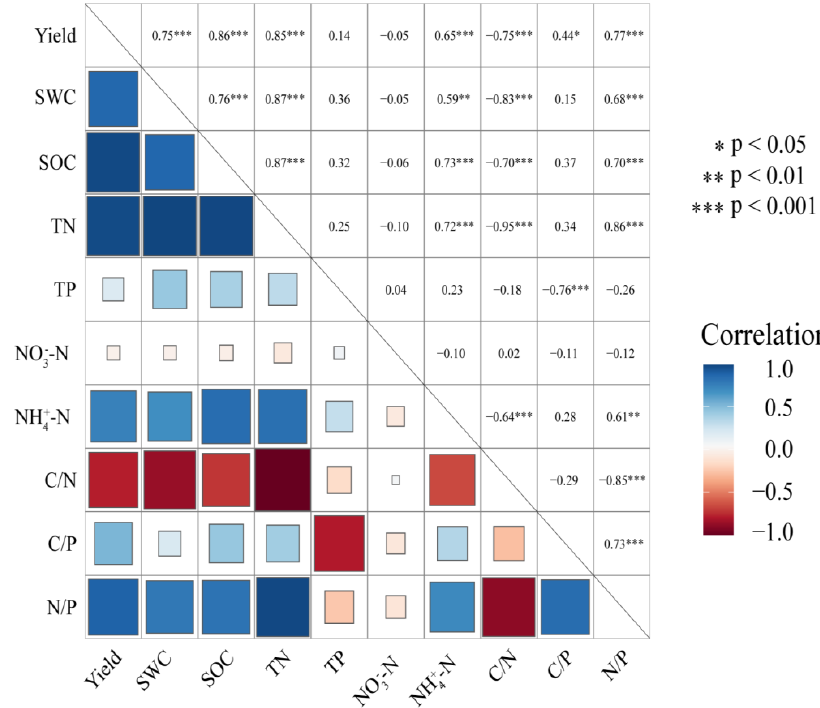
Figure 6. Correlation heat map of spring wheat yield, soil nutrients, and stoichiometric character- istics. SWC: gravimetric soil water content, SOC: soil organic carbon, TN: total nitrogen, TP: total phosphorus, NO 3 − -N: nitrate nitrogen and NH 4 + -N: ammonium nitrogen, C/N: soil carbon and total nitrogen ratio, C/P: soil carbon and total phosphorous ratio and N/P: soil total nitrogen and total phosphorous